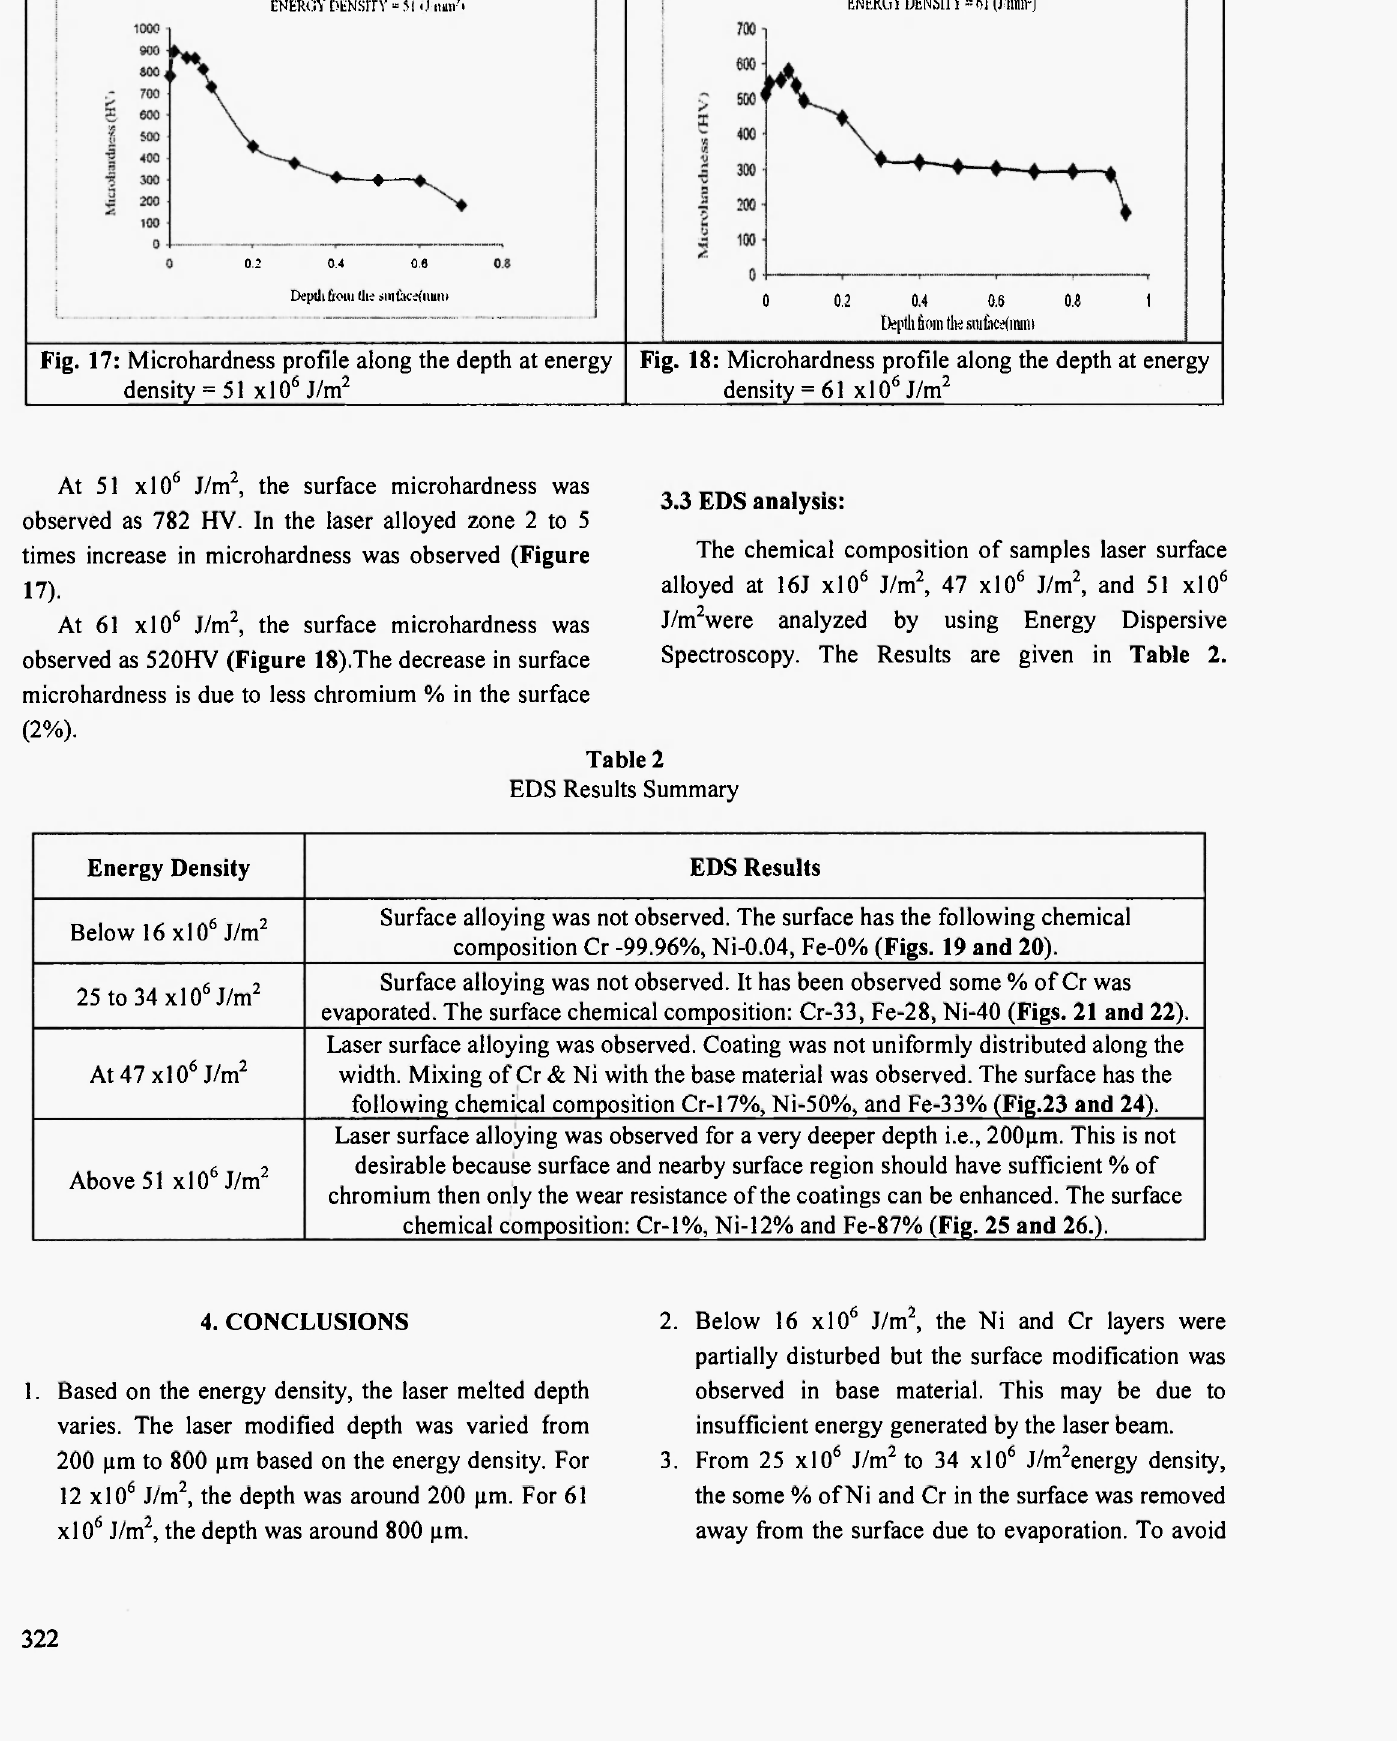
Fig. 18: Microhardness profile along the depth at energy density = 61 xlO 6 J/m